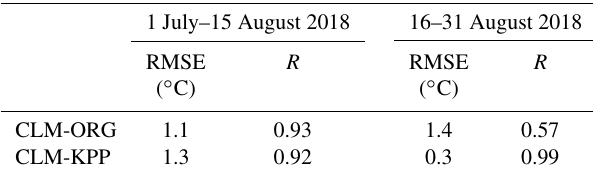
Table 1. RMSE ( ◦ C) and R of temperature profile simulations with CLM-ORG and CLM-KPP for Fog3 Lake for the periods of 1 July– 15 August, and 16–31 August